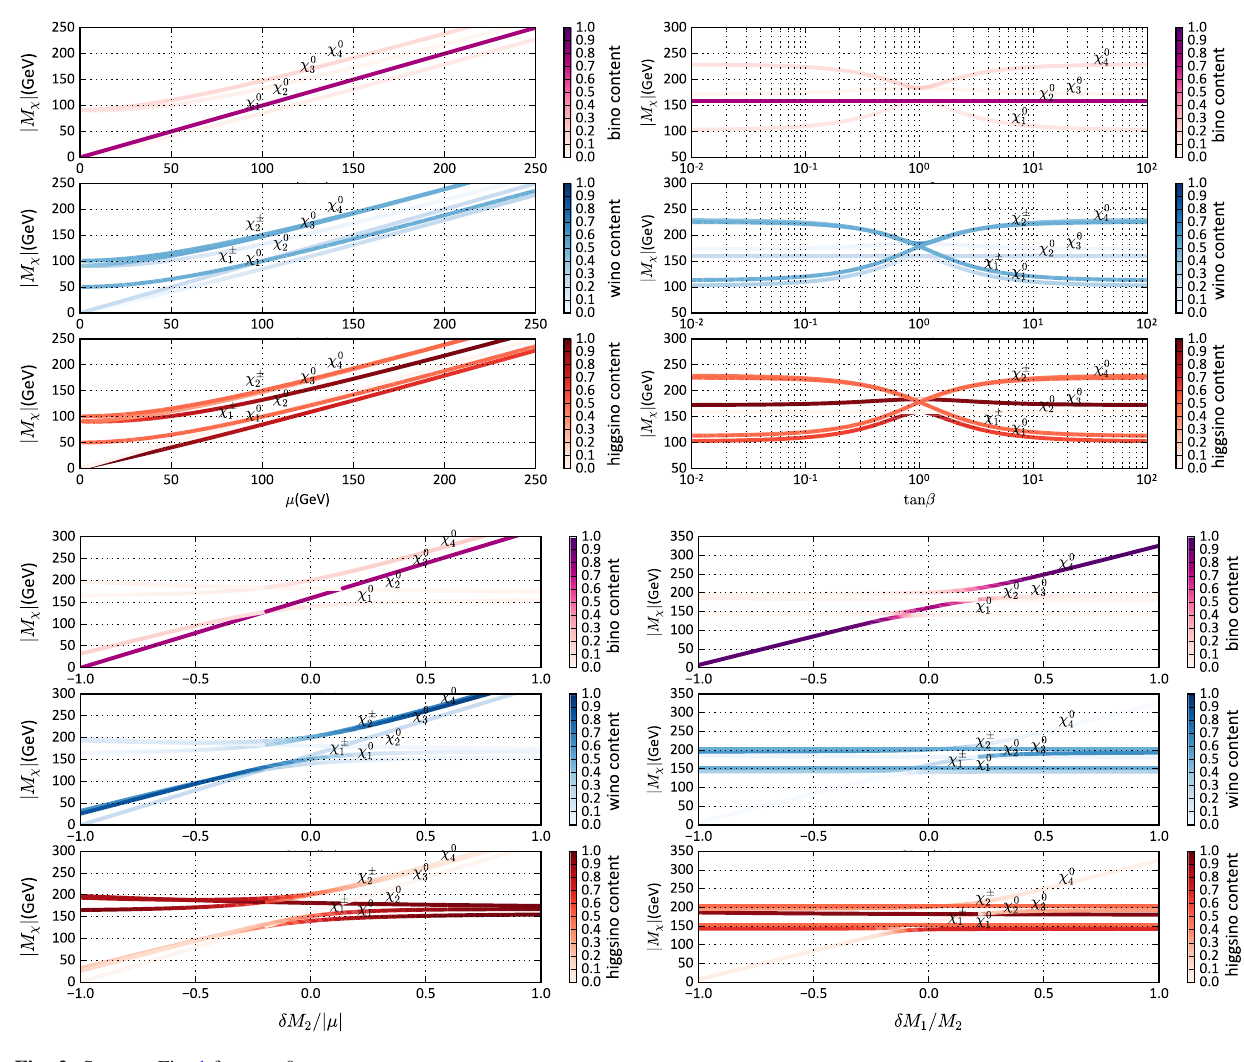
Fig. 2 Same as Fig. 1 for μ < 0